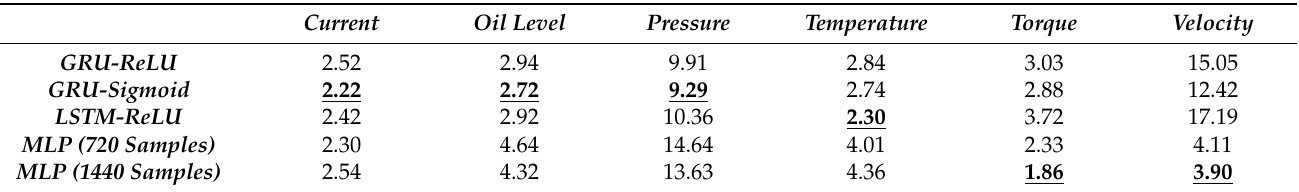
Table 5. Comparison of MAPE results of the prediction models using LSTM, GRU and the feed- forward model presented in this